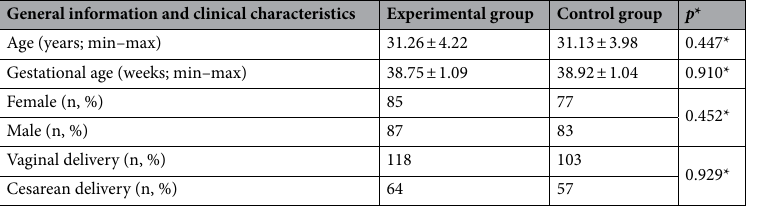
Table 1. General information and clinical characteristics of patients. Values are given as mean ± SD unless otherwise specified. * P -value of < 0.05 was considered statistically significant. Onset time after